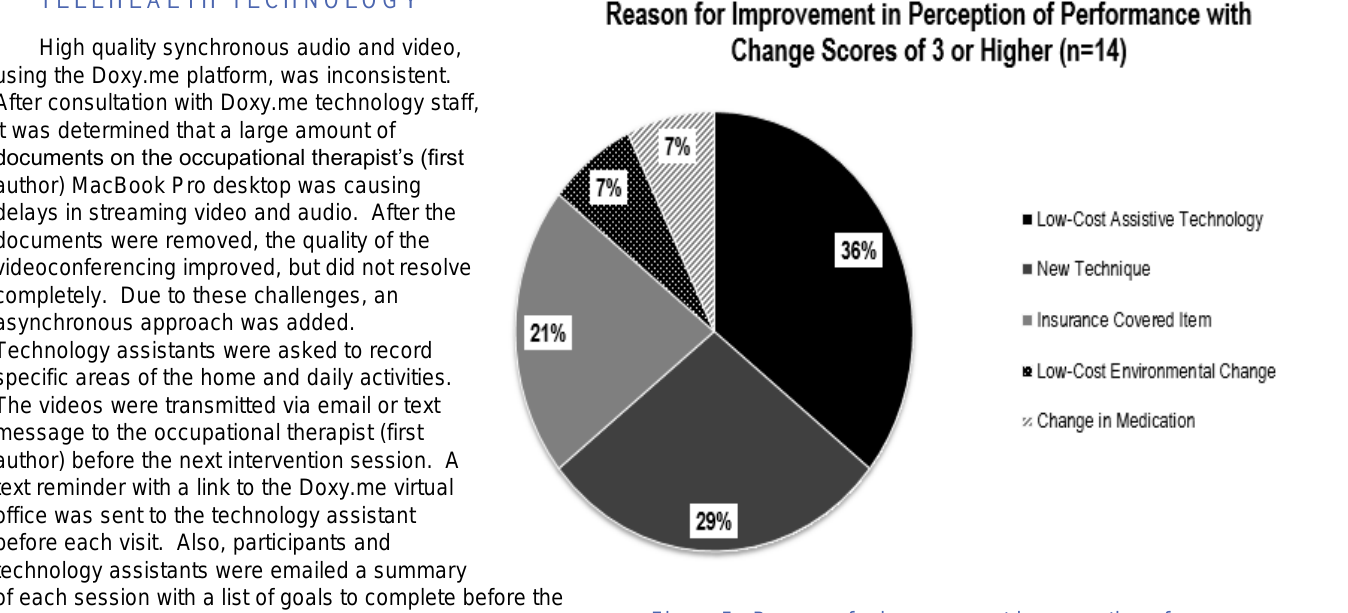
Figure 5. Reasons for improvement in perception of performance change scores of 3 or higher (n=14) using the COPM.